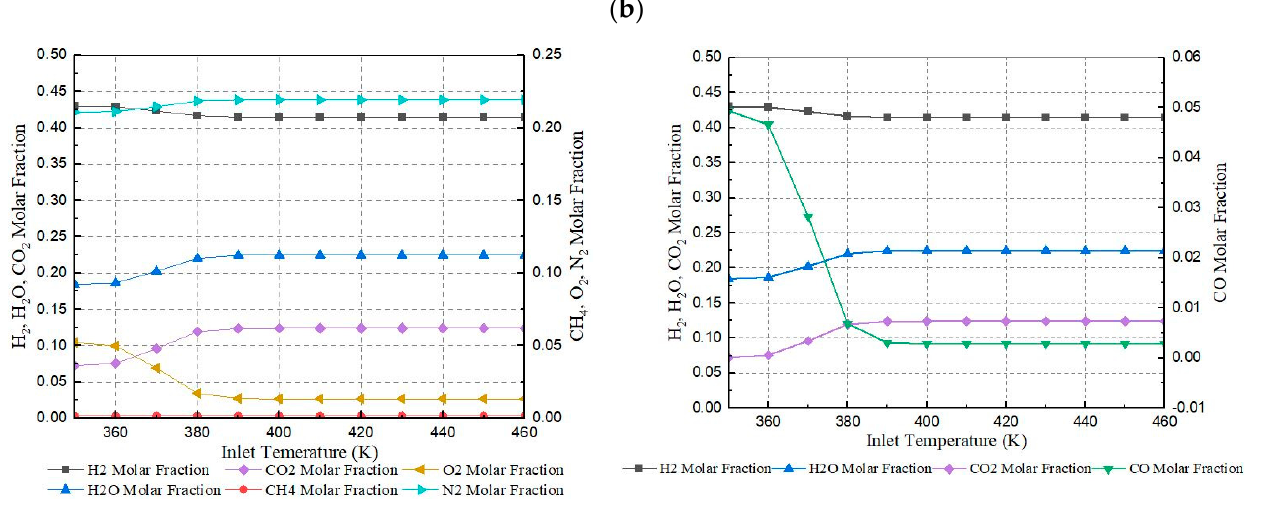
Figure 5. Schematic of ( a ) Case 2 reforming system and Graph of ( b ) molar flow and ( c1 , c2 ) molar fraction of outlet side.